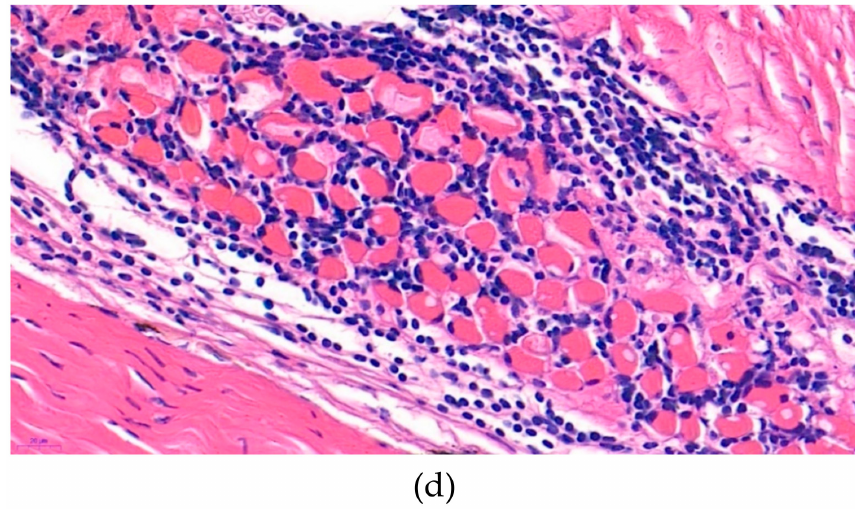
Figure 3. Histopathological analysis of hematoxylin and eosin-stained sections observed under a light microscope (400 × ). ( a ) Rickettsial infection-induced inflammatory lesions in the stratum spongiosum area, which was heavily thickened and showed scale disruption. ( b ) Histology of fish not showing the clinical symptom and having normal scale and stratum spongiosum, which was thinner compared to that in Figure 3 ( a ). ( c ) Congestion of erythrocytes in the outer layer of the dermis with macrophage and mononuclear cell infiltration. ( d ). Infiltration of several mononuclear cells, including lymphocytes, due to inflammation along the muscle tissue.